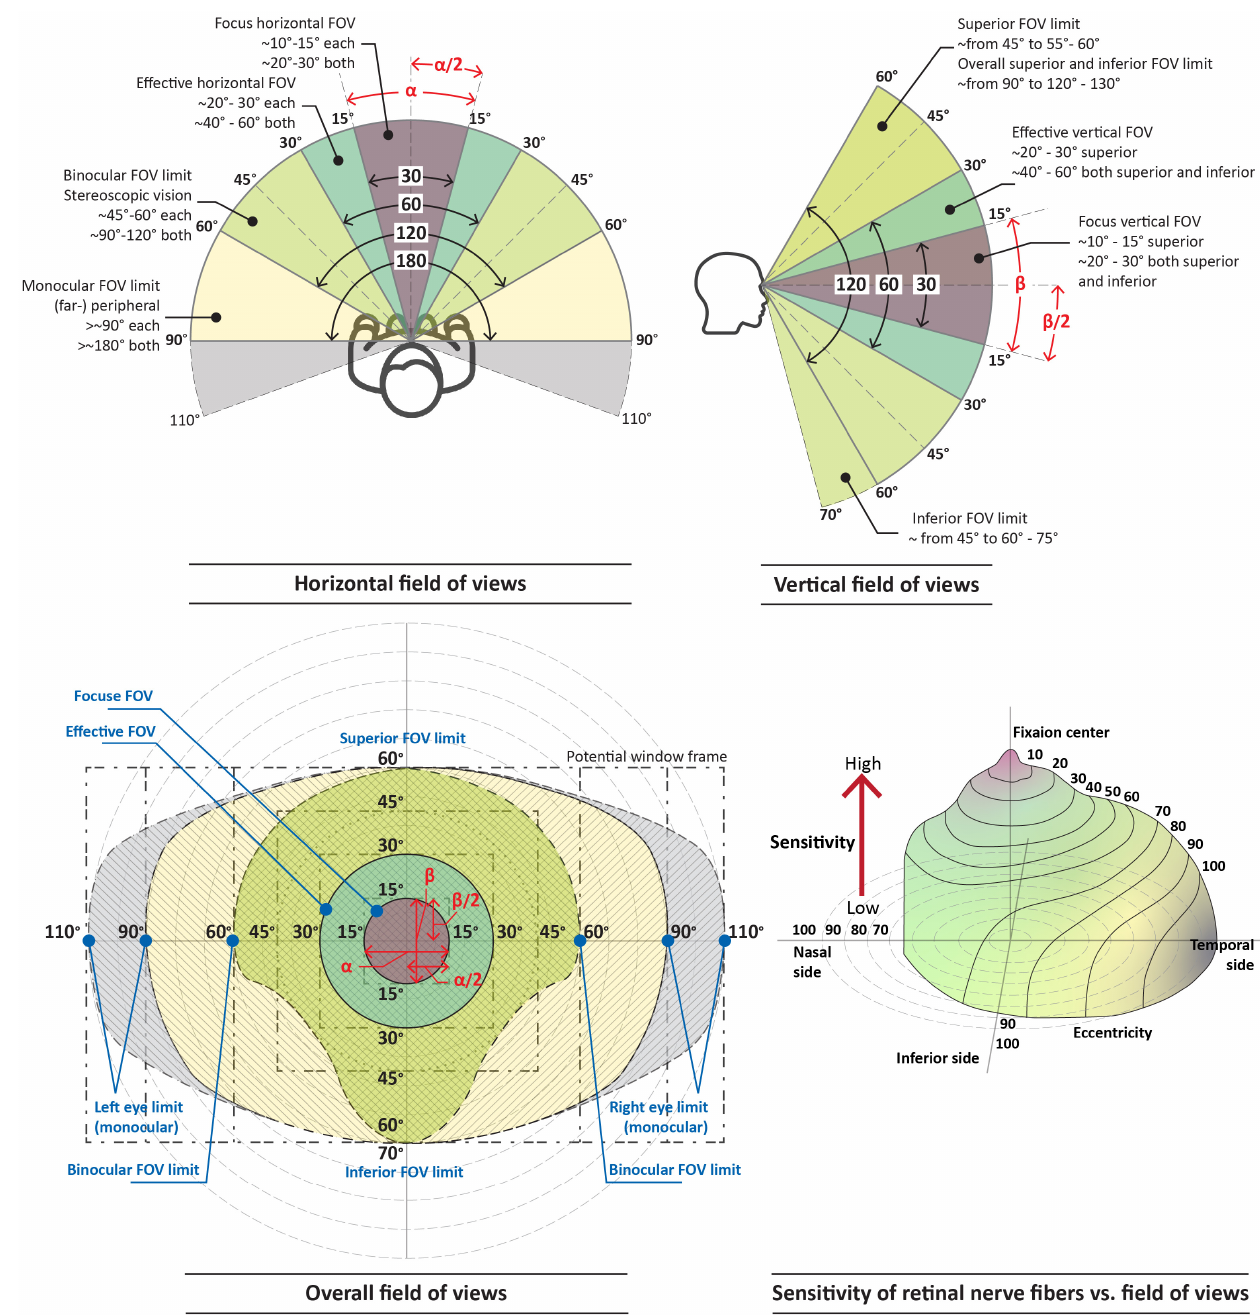
Figure 1. Typical biological vision fields of human eyes and sensitivity of retinal nerve fibers produced based on [28–30,32,36].